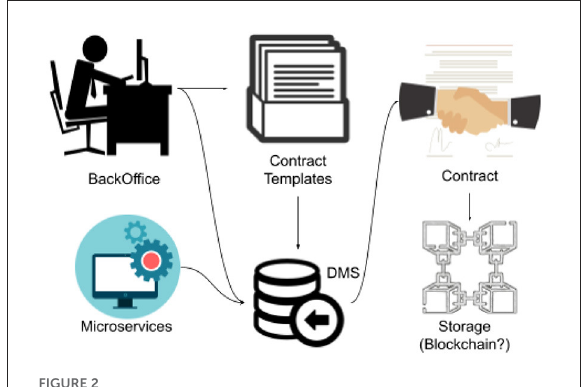
FIGURE2 The proposed macro